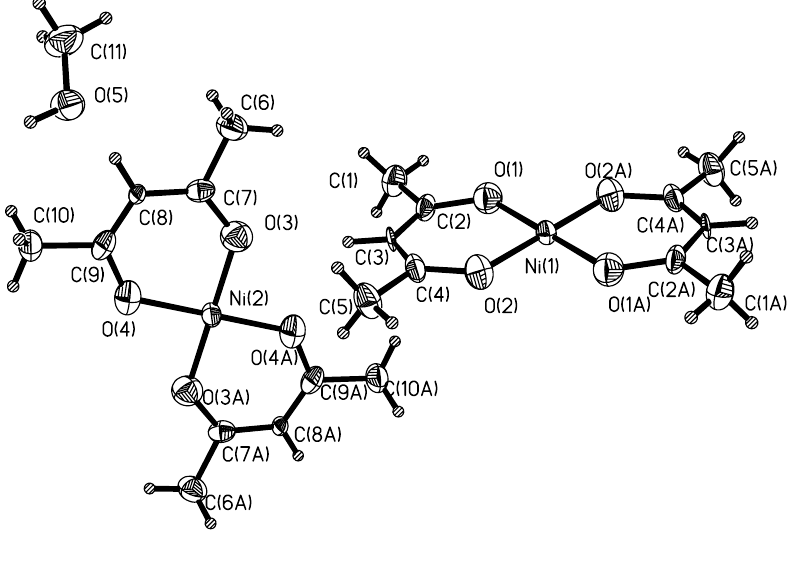
] ·0.5CH OH ( 1 ) at 30% probability 2 2 3